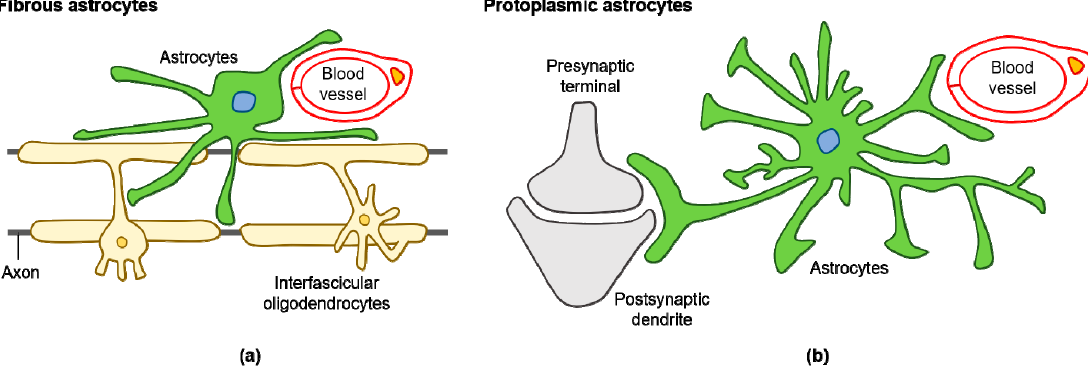
Figure 1. Diagram of fibrous and protoplasmic astrocytes in the central nervous system (CNS): ( a ) fibrous astrocytes in the white matter contact with blood capillaries and axons; ( b ) protoplasmic astrocytes in the gray matter contact with blood capillaries and synapses.